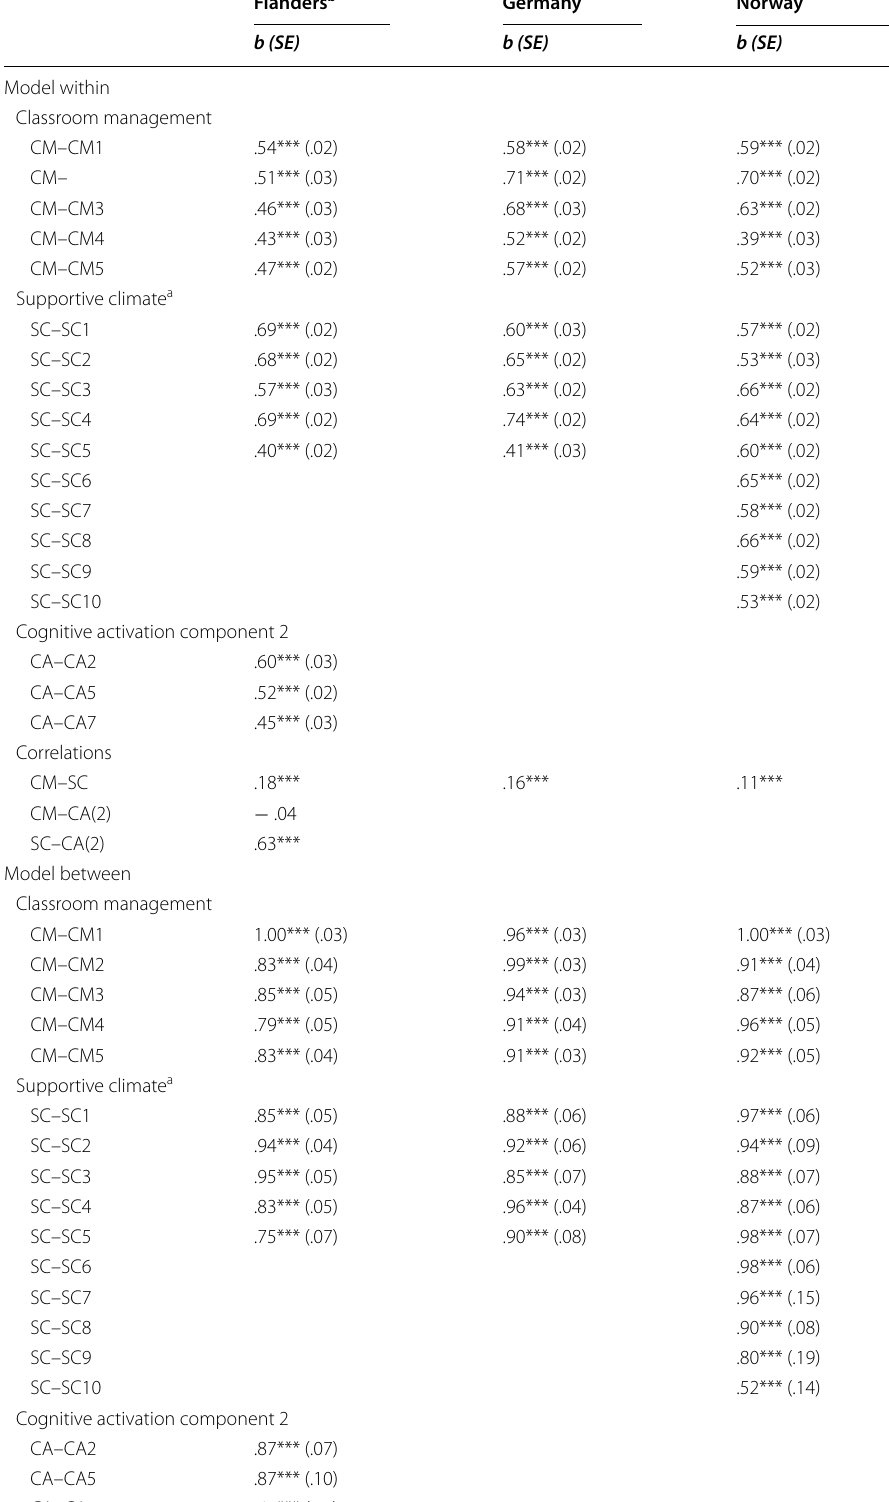
Table 5 Results final CFA analyses RQ1 with adapted scale constructs Flanders b Germany Norway b (SE) b (SE) b